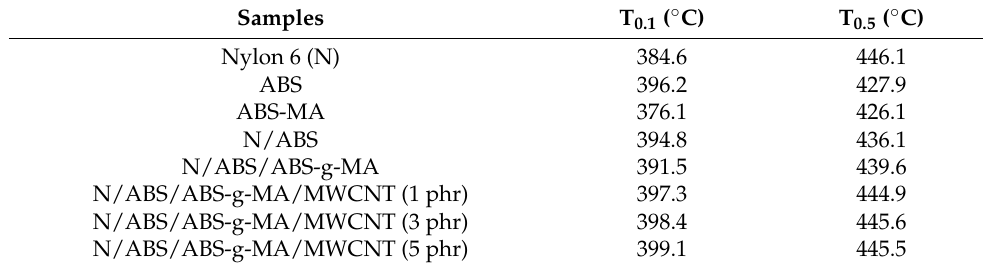
Table 2. Thermal stability results for pure polymers, blends, and nanocomposites. N = Nylon 6. Samples